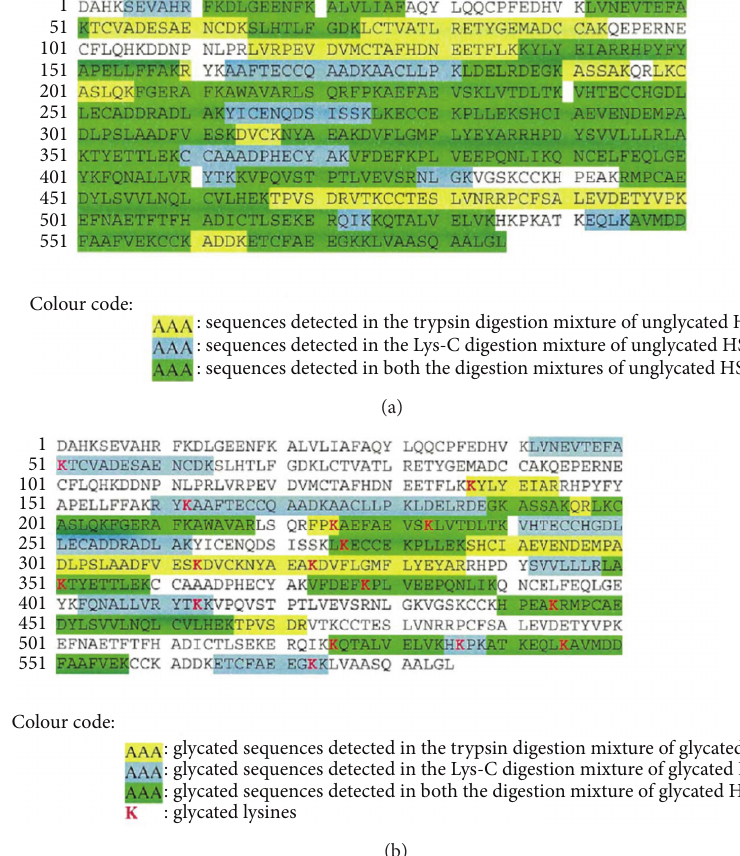
Figure 7: (a) Peptides identified by ESI/LC/MS analyses of unglycated HSA; (b) glycated peptides identified by ESI/LC/MS analyses of glycated HSA. From [24], by kind permission of Springer through RightsLink, License no.